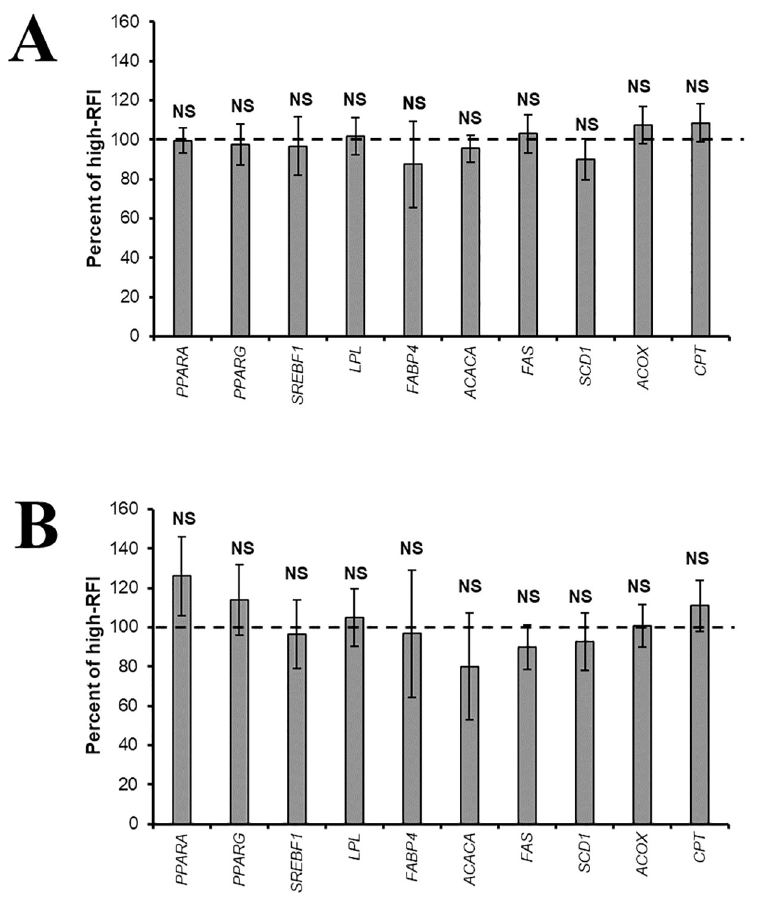
Fig 2. Gene expression in Longissimus muscle of Nellore calves born to cows classified as positive (dotted line) and negative (columns) residual feed intake (RFI) in Year 2. (A) Birth, (B) Weaning. The bars represent the standard deviation of the mean. Values with an asterisk ( � ) differ significantly (P � 0.05) and T indicates a tendency (0.05 < P � 0.15). NS: Not significant (P >